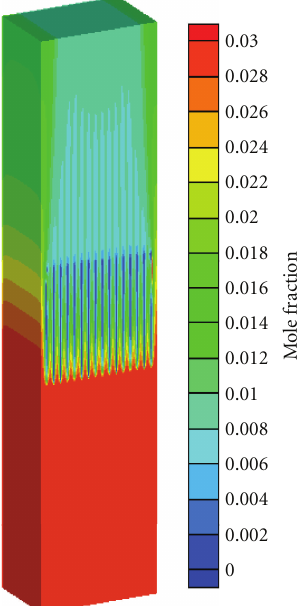
Figure 6: Hydrogen mole fraction contour for simulation per- formed for REKO facility for inlet hydrogen mole fraction 2% and temperature 383 K.